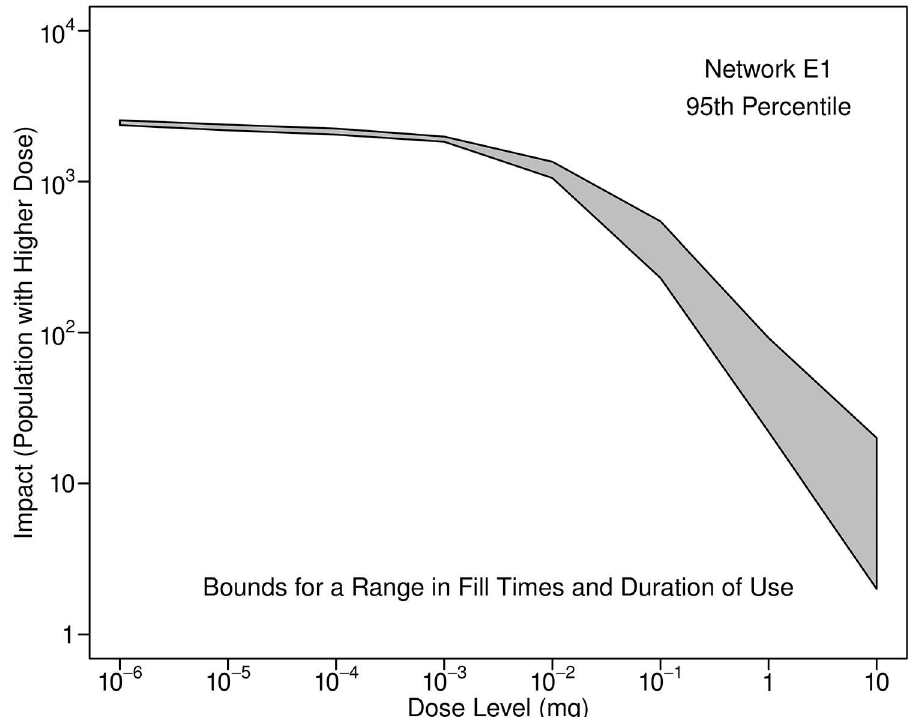
Fig 12. Bounds on estimated 95th percentile impacts associated with humidifier use. The humidifier can be filled at any time and the daily durationof use can have any value from 2 to 10 hours. Results are for Network E1 and an injectionat 0:00 with a mass equal to 10 kg. Twenty percent of the populationis assumed to use ultrasonic